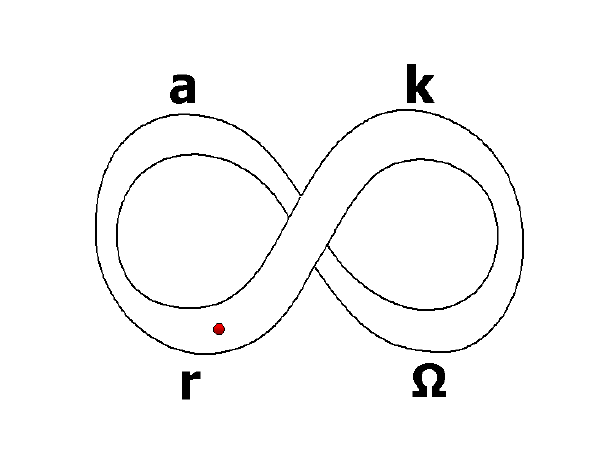
Fig. 1. Depiction of a system moving through the adaptive cycle. As the system moves from r to k, it accumulates capital and grows in size. Following a perturbation (indicated here by the hammer), it undergoes a period of release ( k to W ) and renewal ( W to a ) before entering the r to k trajectory once again. The red and yellow balls indicate alternative stable states of the same system. The labels r and k are derived from the population growth equation, in which r indicates growth rate and k indicates carrying capacity. As the first and last letters of the Greek alphabet, respectively, W and a signify ending and